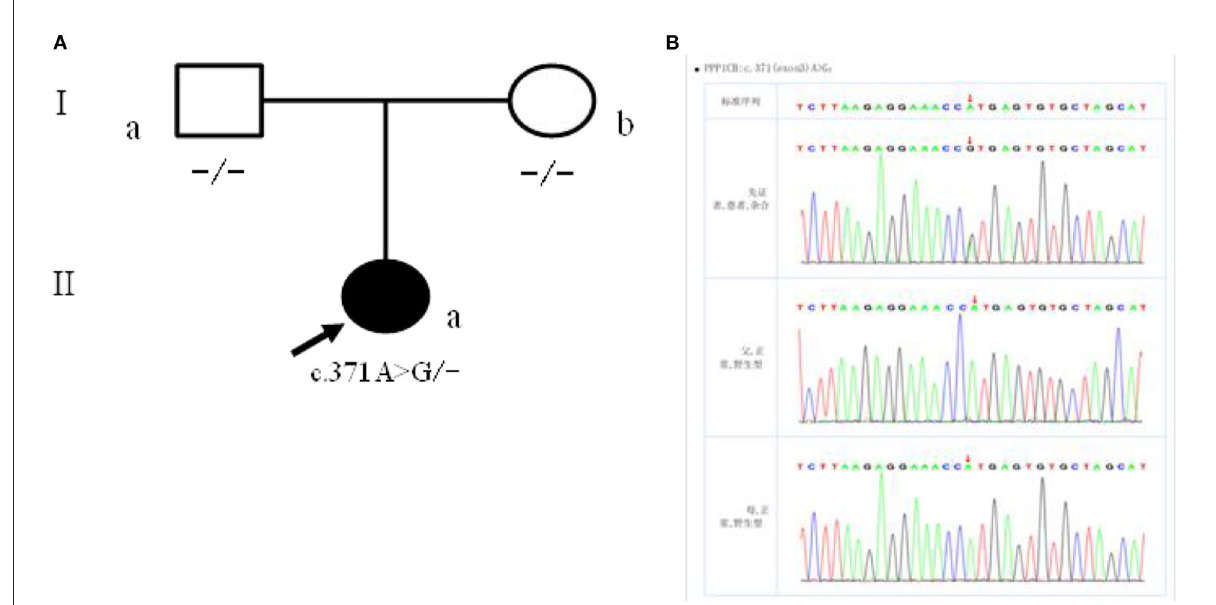
FIGURE4 (A) Children with family figure for NSLH2 clinical phenotype. Her father (I-a) and mother (I-b) had normal clinical manifestations; (B) children with children and parents Sanger sequencing diagram (II-a) for c. 371 A > G heterozygous mutations. Her father (I-a) and mother (I-b) the site are for the wild type.